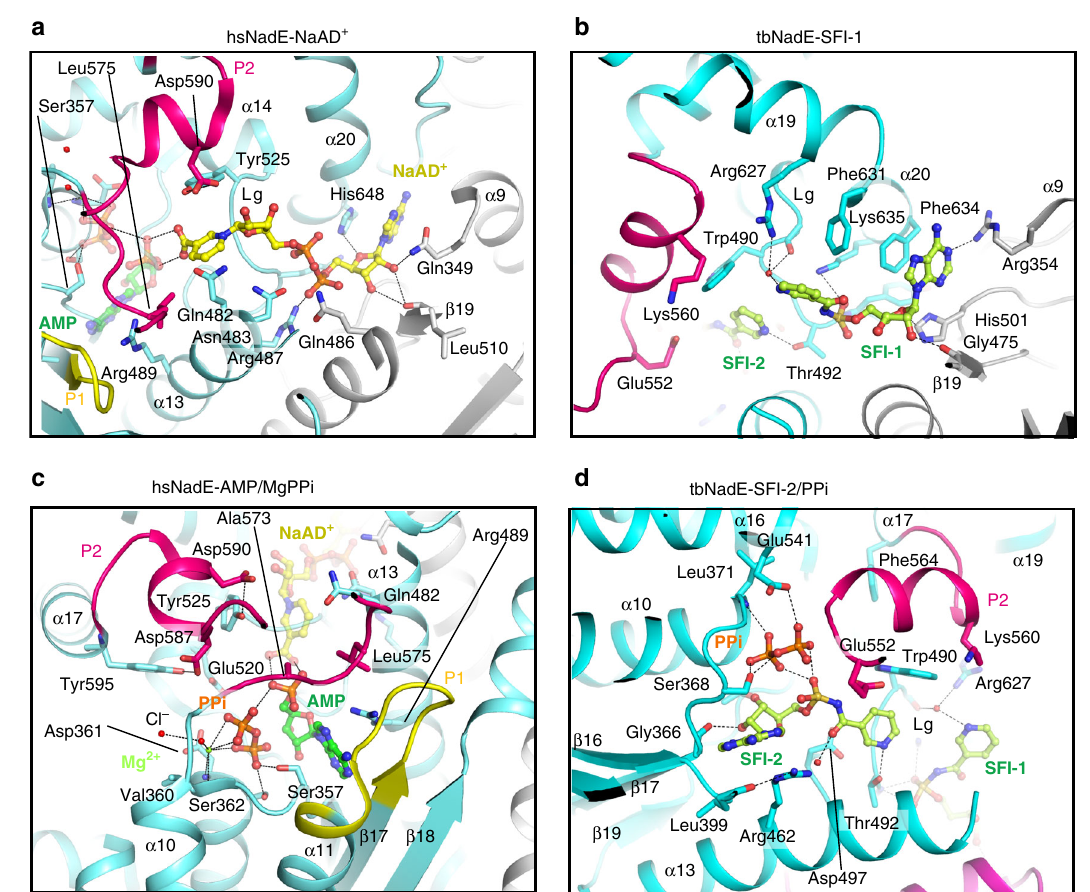
Fig. 4 Structural basis of substrate speci fi city of the synthetase domain. a , b Binding of the NaAD + (yellow stick, a ) and sulfonamide derivative 1 (light green stick, SFI, b ) in NaAD + -binding site of hsNadE and tbNadE, respectively. c , d Binding of the AMP, MgPPi (green/orange stick, green sphere) in hsNadE ( c ) and SFI, PPi in tbNadE ( d ). Cl − atom hydrogen bonds to Mg 2 + is in red sphere. In the tbNadE – SFI complex, the fi rst SFI molecule is bound in the NaAD + -binding site ( b ) and the second SFI together with PPi is bound in the ATP-binding site ( d ) in a similar manner than the synthetase intermediate analog. This results in the ordering of the P2 loop (pink SFIs exploit the same hydrophobic and hydrophilic contacts as NaAD + -AMP in the previously reported tbNadE complex with NaAD + , AMP, PPi structure (PDB code 3SZG, Supplementary Fig. 5d, e) 27 . Closure of the P2 loop observed in subunit B syn reveals two close contacts, the fi rst between the P2 loop residue Glu552 TB and N -(nicotinyl)sulfamoyl linkage of SFI bound in the